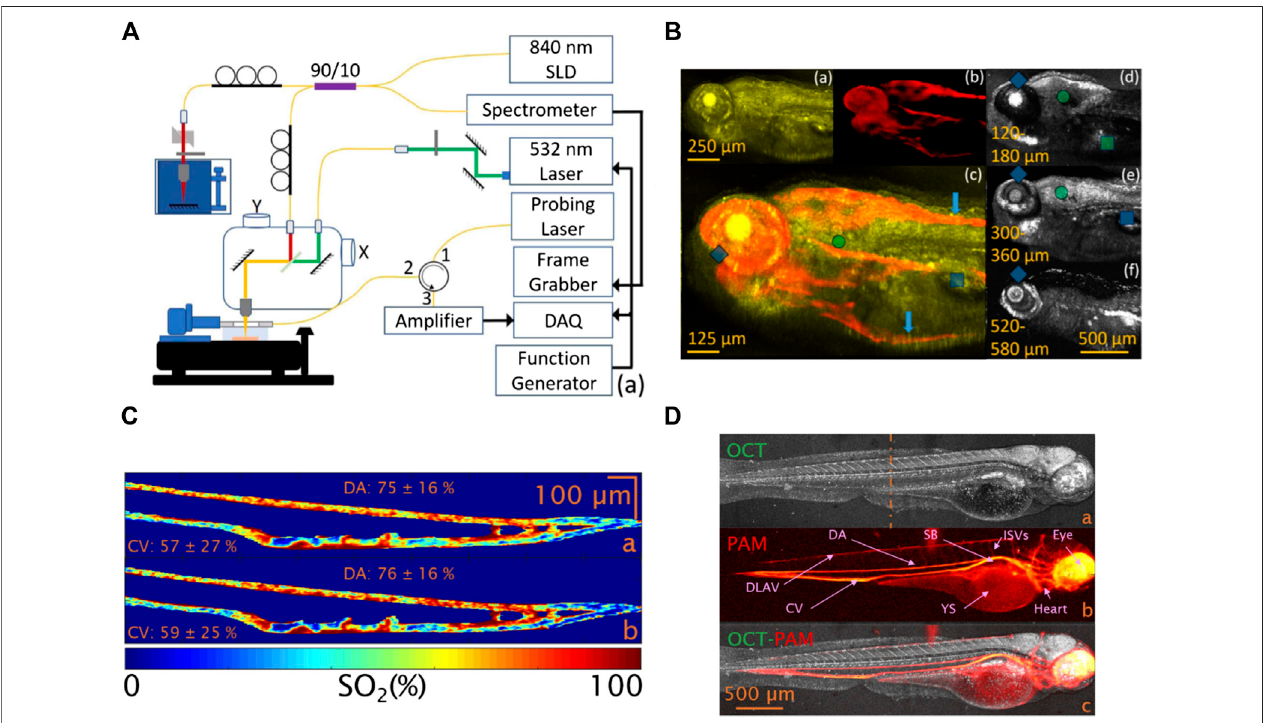
FIGURE5| (A) Schematicofthe re fl ection-modePAM-OCT system [130]; (B) images ofazebra fi sh larva. (a) OCTimage; (b) PAM image; (c) color blended PAM- OCT image using (a) and (b) . (d – f) Images of OCT integrating 60 μ m depth range. Reprinted with permission from [130]. (C) Oxygenation map of a zebra fi sh larval tail. The image is acquired after spectral unmixing using the absorption coef fi cients of human (a) and zebra fi sh blood (b) , respectively [132]. (D) OCT-PAM image of a zebra fi shlarva. (a) OCTaverageintensityprojection, (b) PAMmaximumamplitudeprojection,and (c) multimodalOCT-PAM.Reprintedwithpermissionfrom[132].